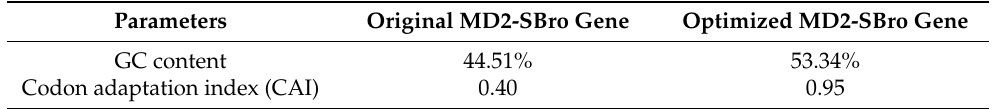
Table 1. Gene optimization of the MD2-SBro gene.